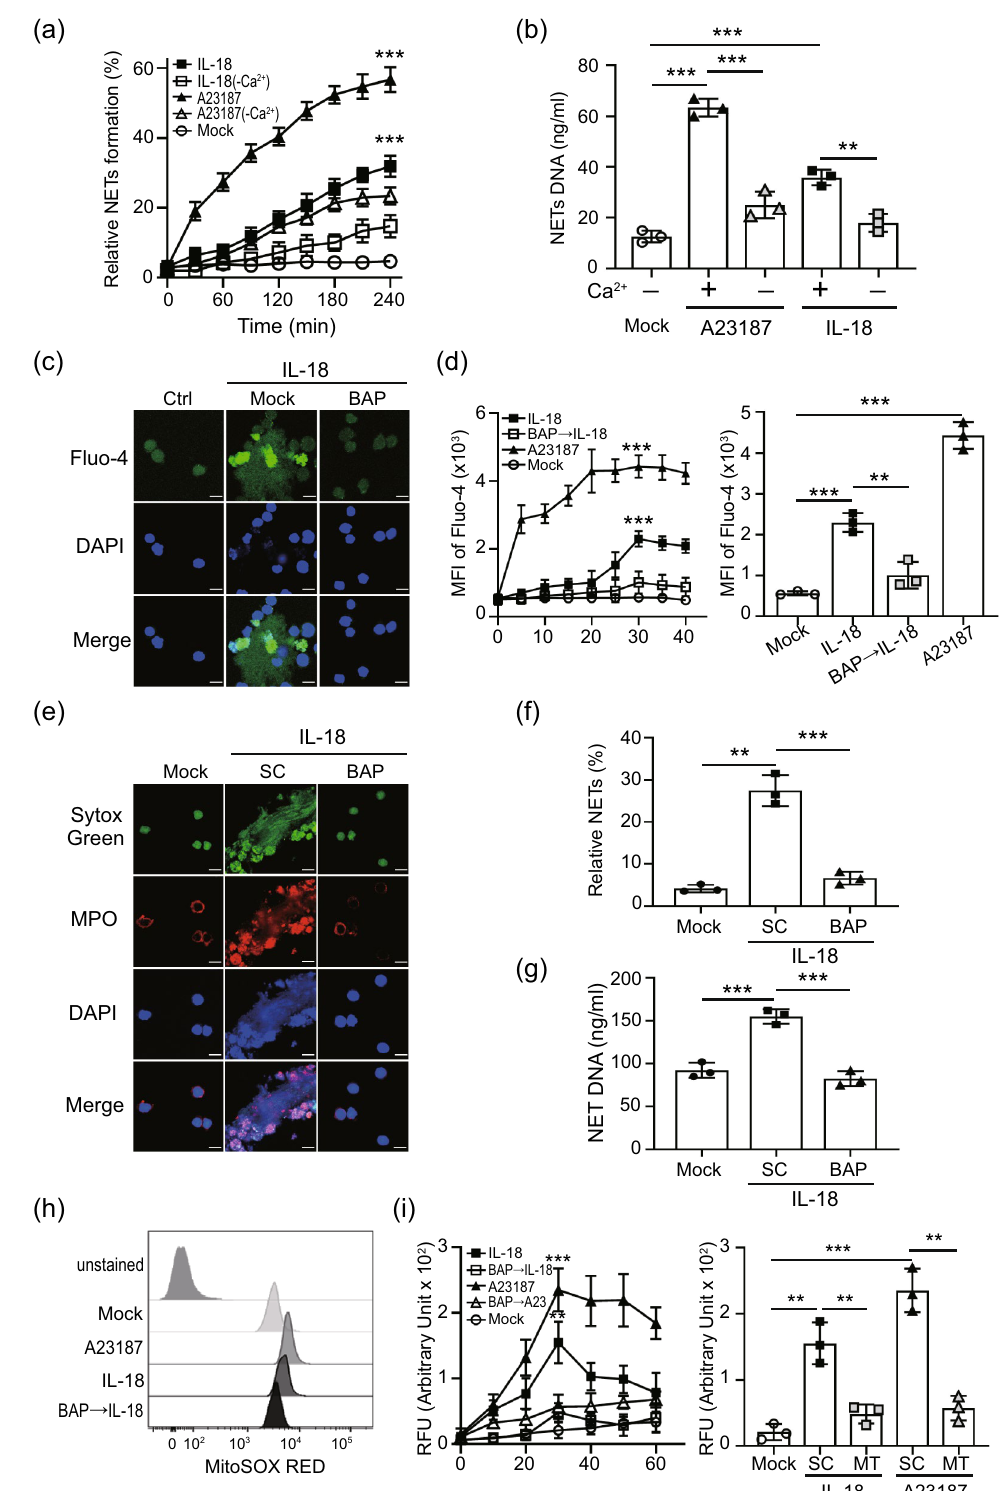
Figure 3. IL-18 mediated NETs formation was required calcium. ( a , b ) Neutrophils were stimulated with A23187 or IL-18 in the presence or absence of calcium. ( a ) The dynamic of NETs formation and (b) NETs DNA release was quantified. ( c ) dHL-60 cells were stimulated with IL-18 in the presence of intracellular calcium chelator BAPTA-AM (10 μM). The calcium mobilization in Fluo-4 AM loading neutrophils was detected by confocal microscopy. ( d ) The dynamic of calcium mobilization production in neutrophils was analyzed by using Fluo-4 AM dye with flow cytometry (left panel). At 30 min post-treatment, IL-18 induces a higher calcium mobilization compared with control cells, which was declined in the presence of calcium chelator BAPTA-AM (10 μM) (right panel). Chelation of intracellular calcium reduces IL-18 mediated- ( e , f ) NETs formation, ( g ) NETs DNA release, and ( h , i ) mitochondrial ROS production. All experiments were performed in triplicate, and data are presented as the mean ± SD. The scale bar in the IFA image represents 5 μm. * P < 0.05, ** P < 0.01, *** P < 0.005. MT, MitoTEMPO; SC, solvent